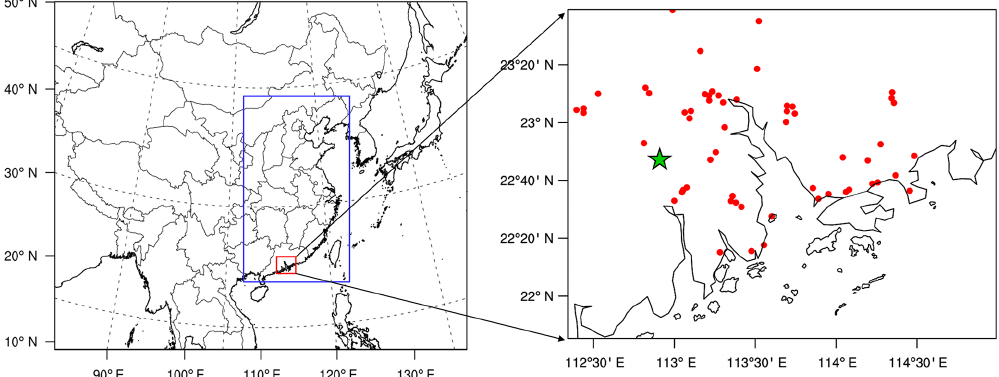
Figure 1. Model domains and locations of the monitoring sites. The green star represents the Heshan site and red dots represent official monitoring sites in the PRD region from the Ministry of Ecology and Environment of